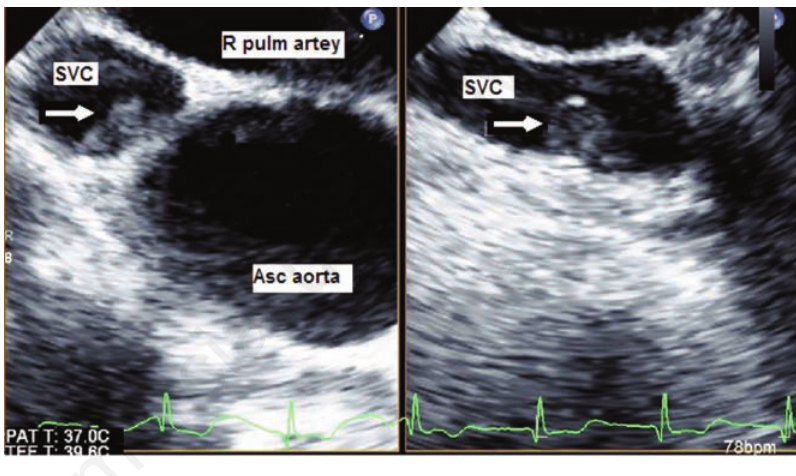
Figure 1. Great vessels view of trans-esophageal echocardiogram showing thrombus (arrow) in superior vena cava (SVC), ascending aorta, and right pulmonary